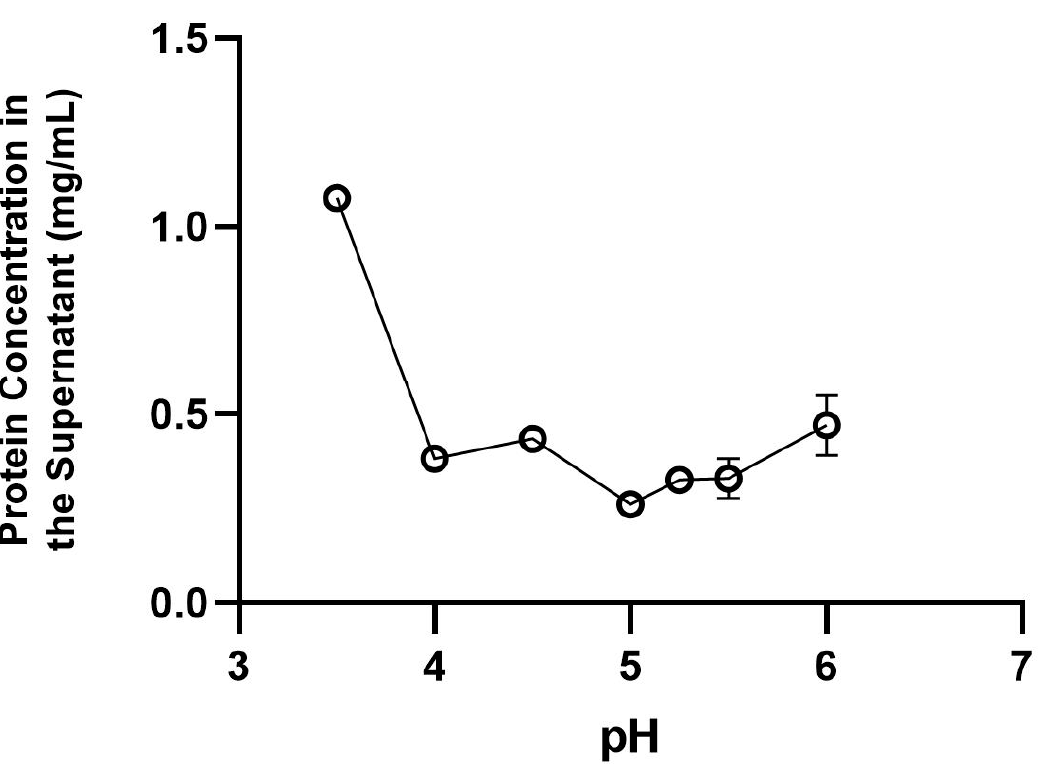
Figure 1. Effect of the pH conditions on protein transference from the powder to the supernatant.